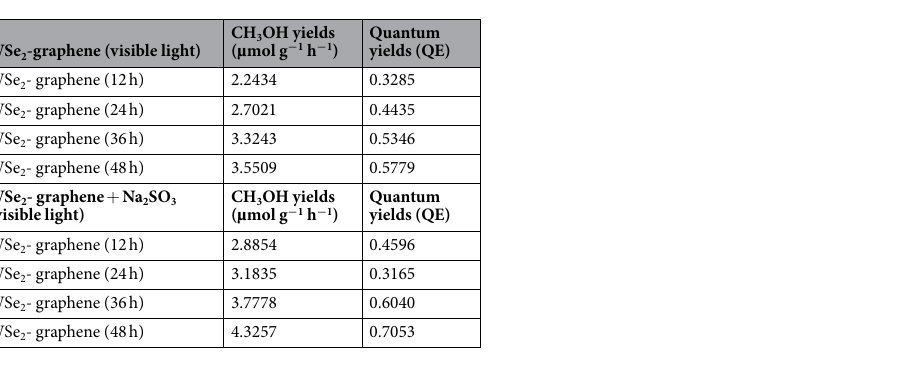
Table 1. Methanol Production condition with methanol yields and quantum yields under visible light.